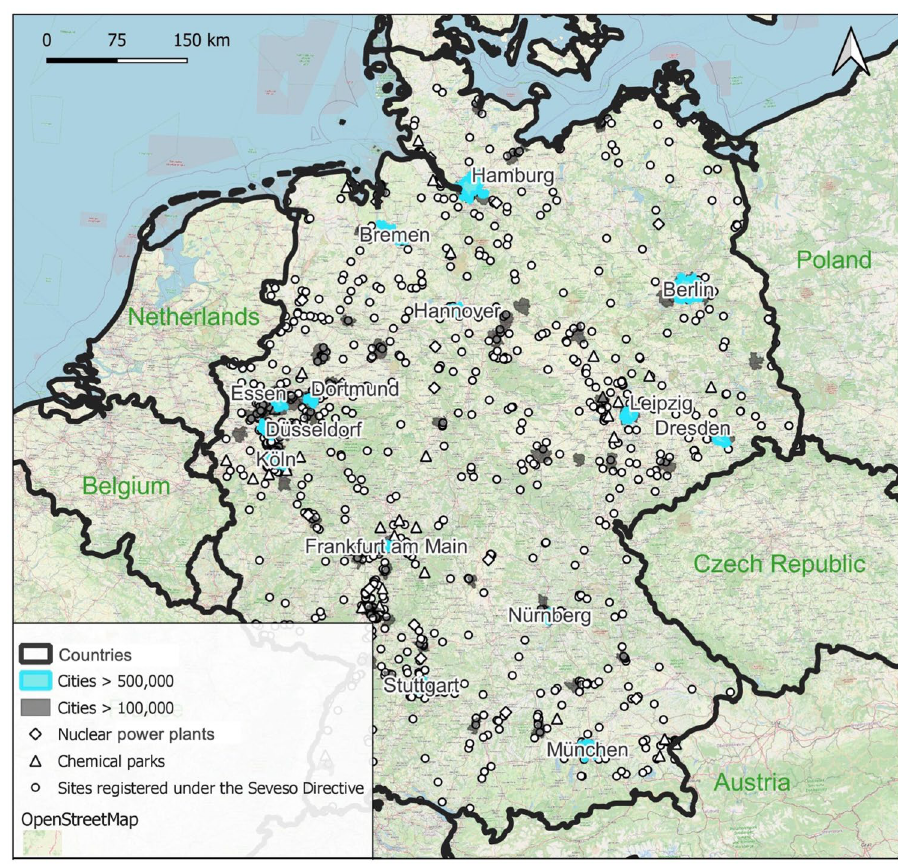
Fig. 2 Location of nuclear power plants (NPP), chemi- cal parks, and sites registered under the Seveso Directive in